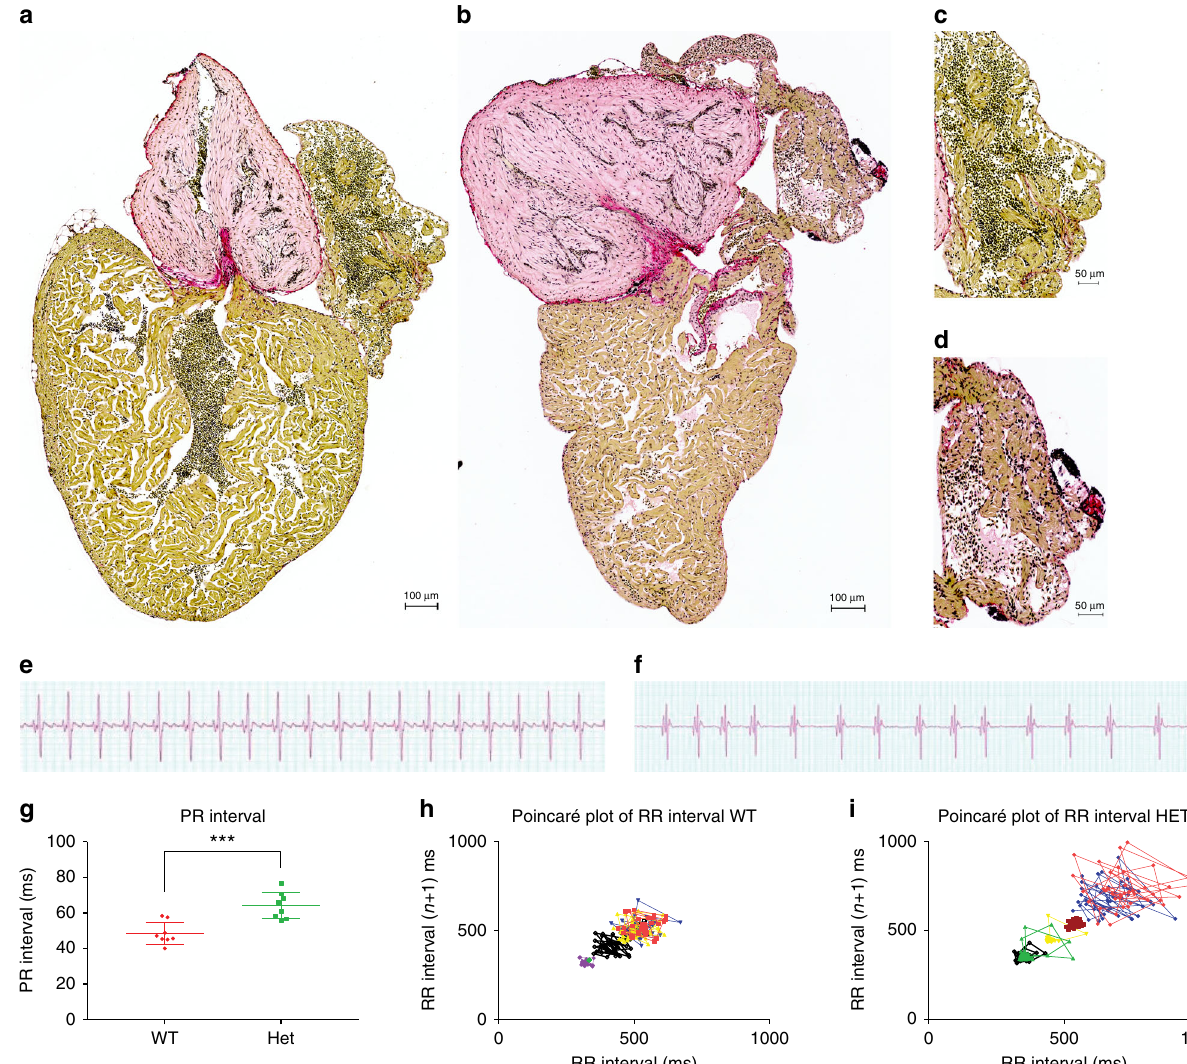
Fig. 3 Truncating mutation in ttn.2 cause increase fi brosis and electrophysiological defects in adult heterozygous mutants. Sirius staining of isolated whole hearts from adult WT ( a ) and heterozygous mutant siblings ( b ) show increased fi brotic lesions in the heterozygous heart ( b ) compared with the WT ( a ). This increase appears to be more pronounced in the atria of the heterozygous hearts ( d ) ( n = 4) compared with that of the WT siblings ( c ) ( n = 4). Scale bars: a , b 200 µ m; c , d ; 50 µ m. ECG surface recordings of adult WT fi sh ( e ) revealed a regular ECG pattern with well-de fi ned P-waves and QRS complexes, with regular PR intervals ( g ) and RR intervals, with low beat-to-beat variability, as shown by the Poincaré plot ( h ), indicative of a regular heart rhythm ( n = 8). In the heterozygous siblings, the ECG pattern was equally well de fi ned ( f ), but with a larger PR interval, compared with the WT siblings. Furthermore, the RR interval and beat-to-beat variability was irregular, as demonstrated by the Poincaré plot ( i ), indicating an irregular heart rhythm in the heterozygous siblings ( n =